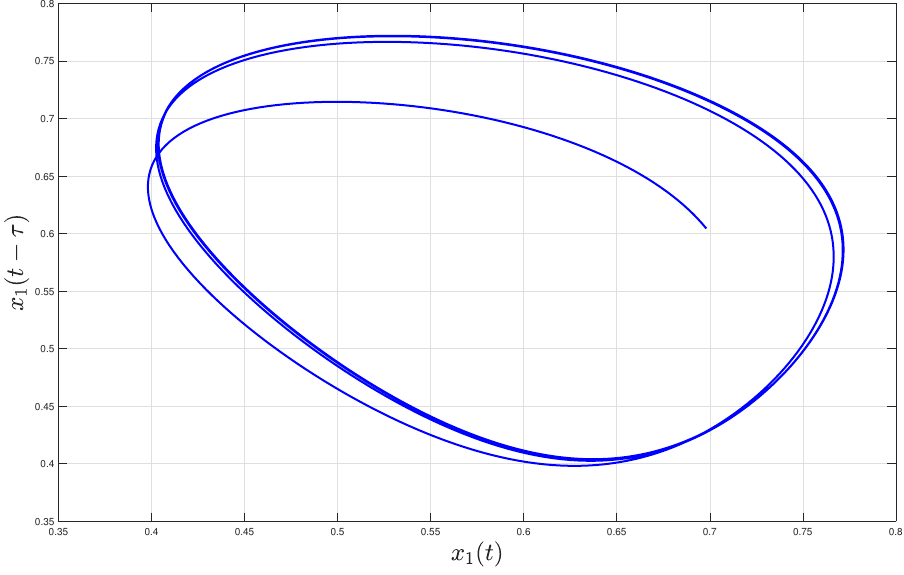
Figure 4. Phase diagram of x 1 ( t ) with 0.6 = τ > τ ∗ = 0.5303, the system with a Hopf